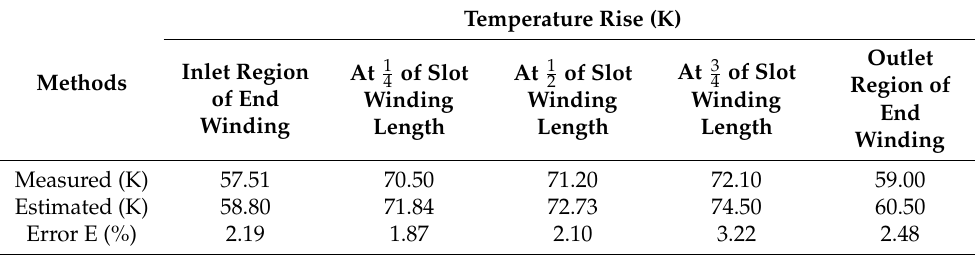
Table 14. Comparison of A4 model estimated and measured winding temperature rise for